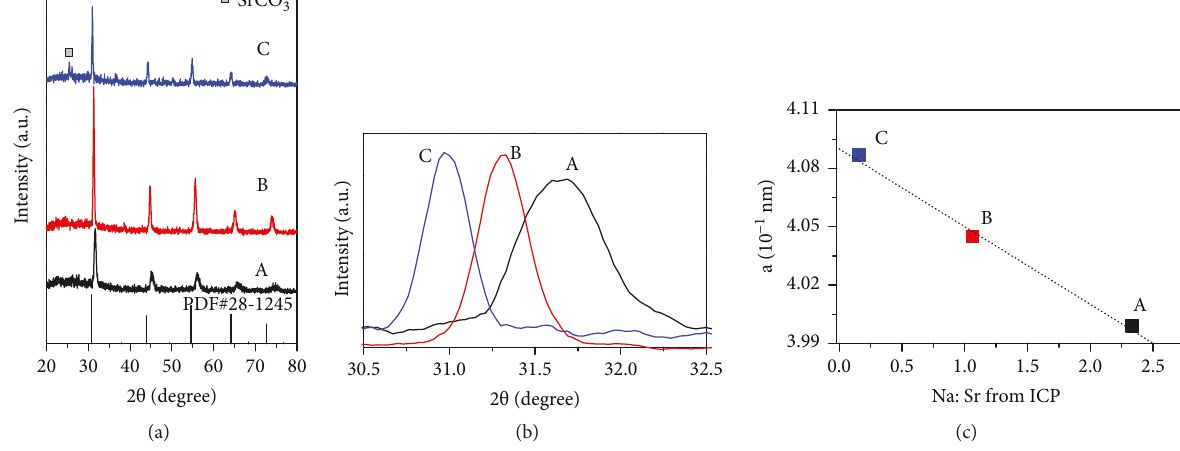
Figure 1: (a) XRD patterns, (b) enlarged view of main peak, (c) lattice parameter vs. Na:Sr ratio of samples prepared from di ff erent ratio of SrCO to sodium niobate of (A) 1 :2, (B) 2 :2, and (C) 4 :2. The standard XRD pattern of Sr 3 in Figure 1(a).